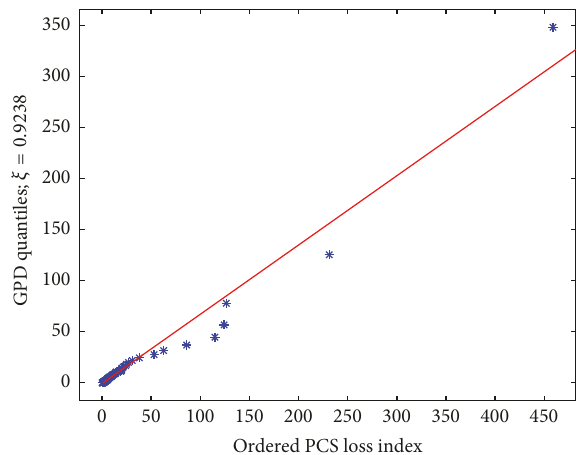
Figure 11: QQ-plot of PCS loss index quantiles against 𝐺 ̂𝜉,̂𝜎 quan-